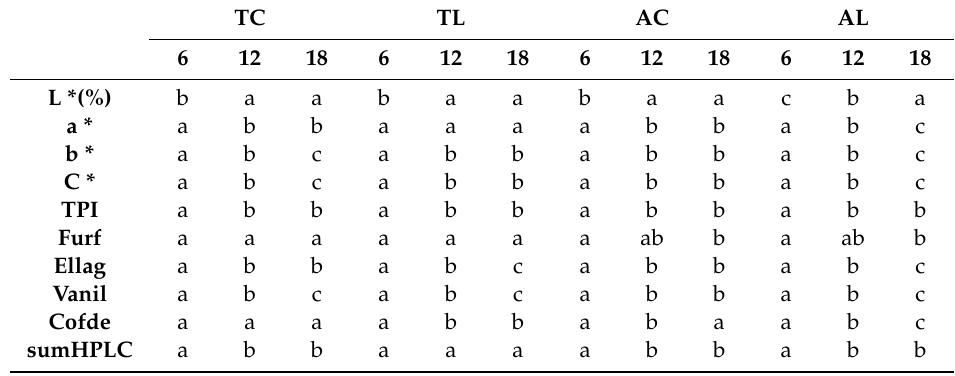
Table 3. Di ff erences observed for each samples group (technology vs. wood) during the ageing